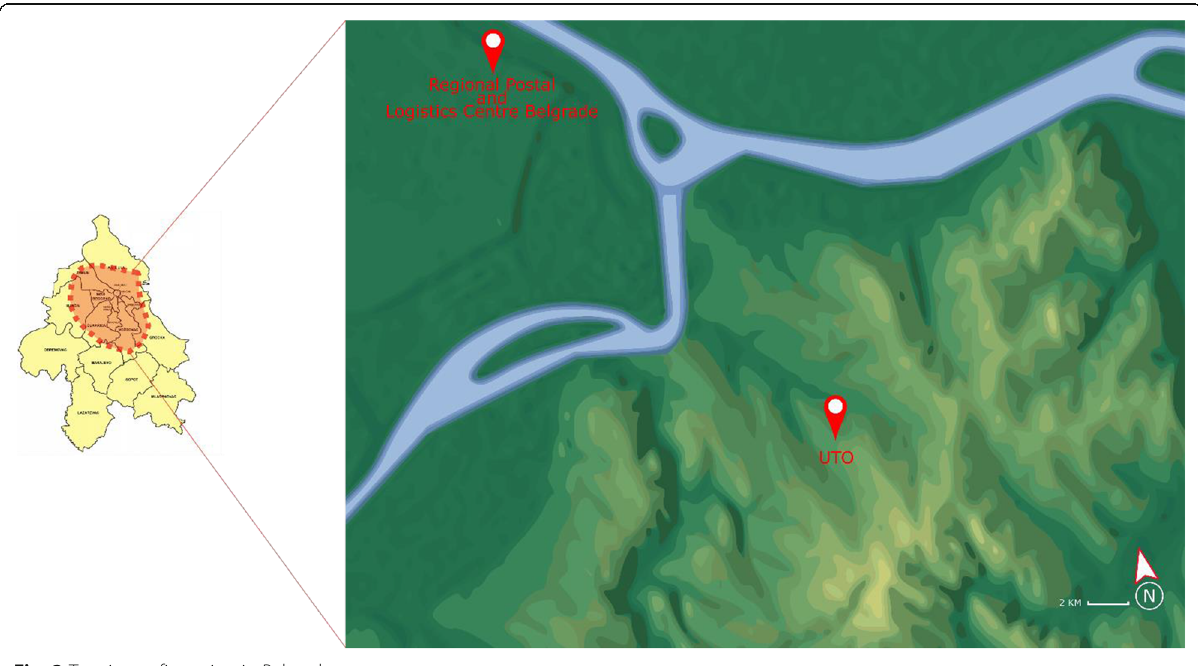
Fig. 3 Terrain configuration in Belgrade